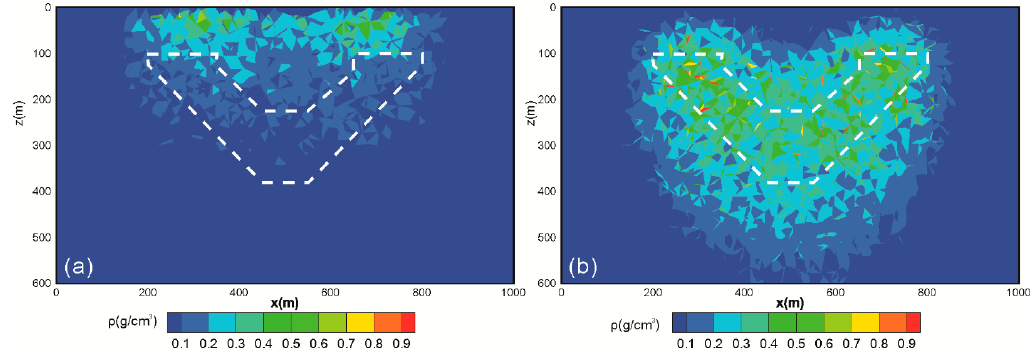
Figure 4. Inversion results with λ = 0: ( a ) conventional strategy, and ( b ) gradient-based strategy. Appl. Sci. 2021 , 11 , x FOR PEER REVIEW